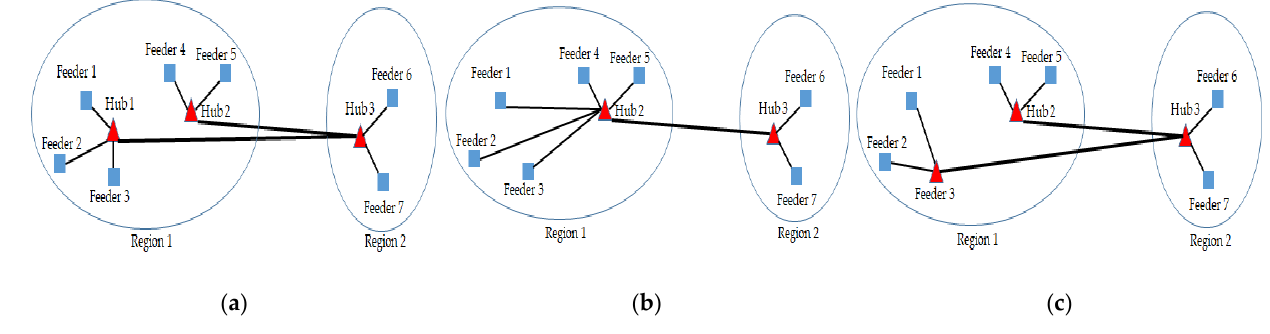
Figure 2. Schematic diagram of a case considering hub failure. For any feeder port